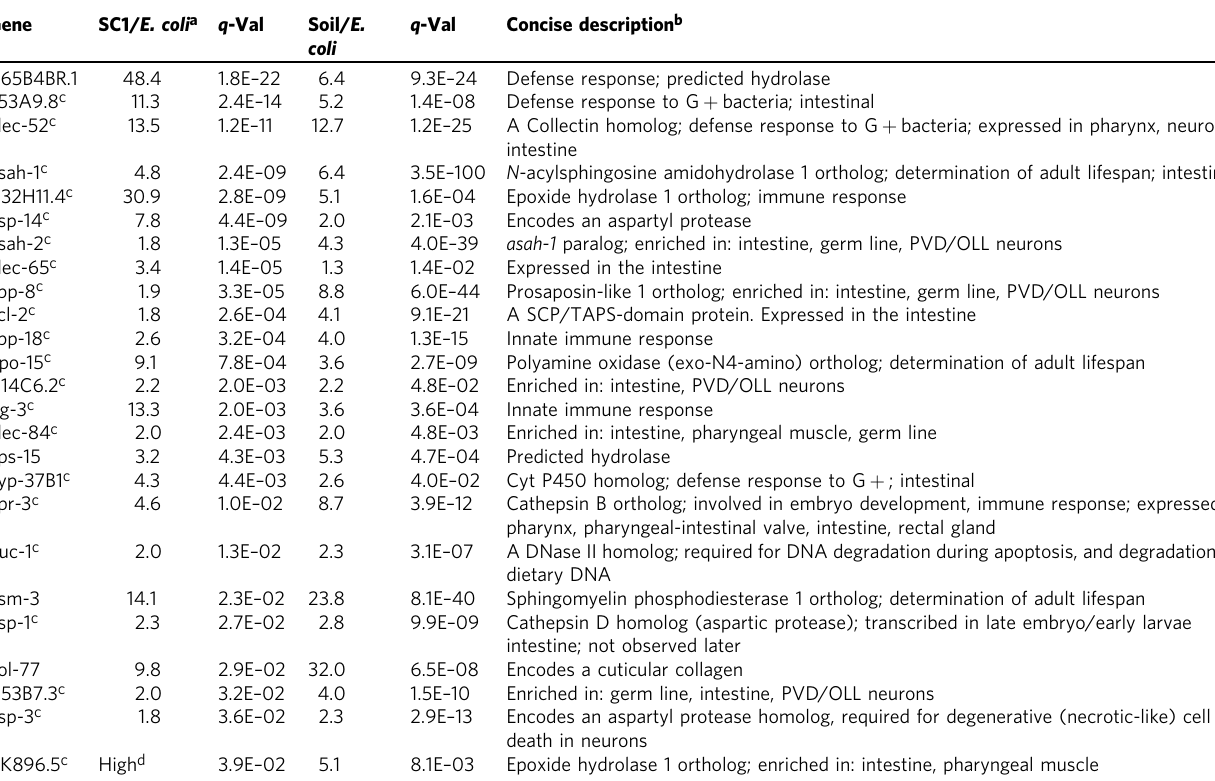
Table 1 Genes upregulated during interactions with complex microbiotas Gene SC1/ E. coli a q